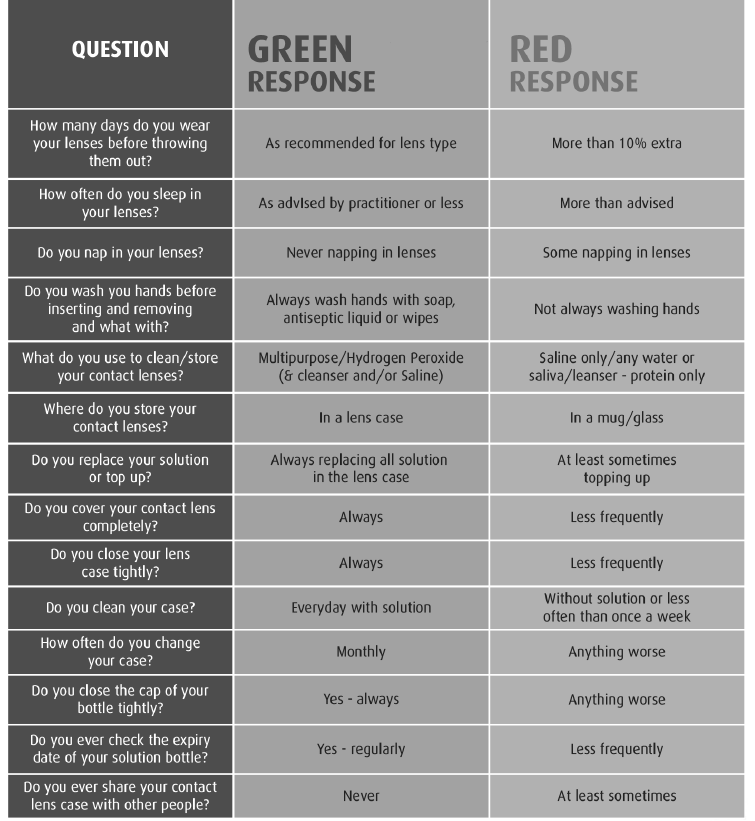
Figure 3. The Traffic Light Compliance Model, developed by Dr. Philip Morgan